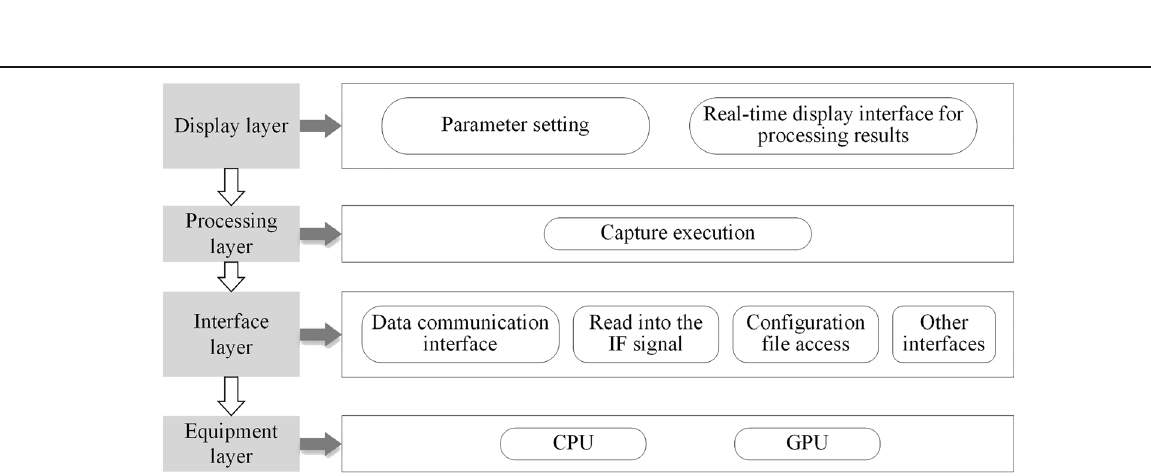
Fig. 5 System prototype architecture diagram. The figure shows the system prototype of the compatible capture system designed in this article, which is mainly composed of the display layer, the processing layer, the interface layer, and the device